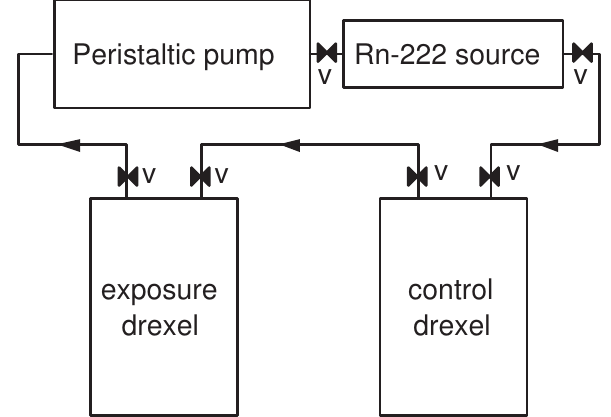
Figure 3. A scheme of the exposure system. In the beginning of the exposure, the activity of the radon source was promptly introduced in the system by the pump. Then, the valves “V” were closed, and the system was disconnected. Table 2. Exposure conditions of the four experiments for estimation of the partition coefficients